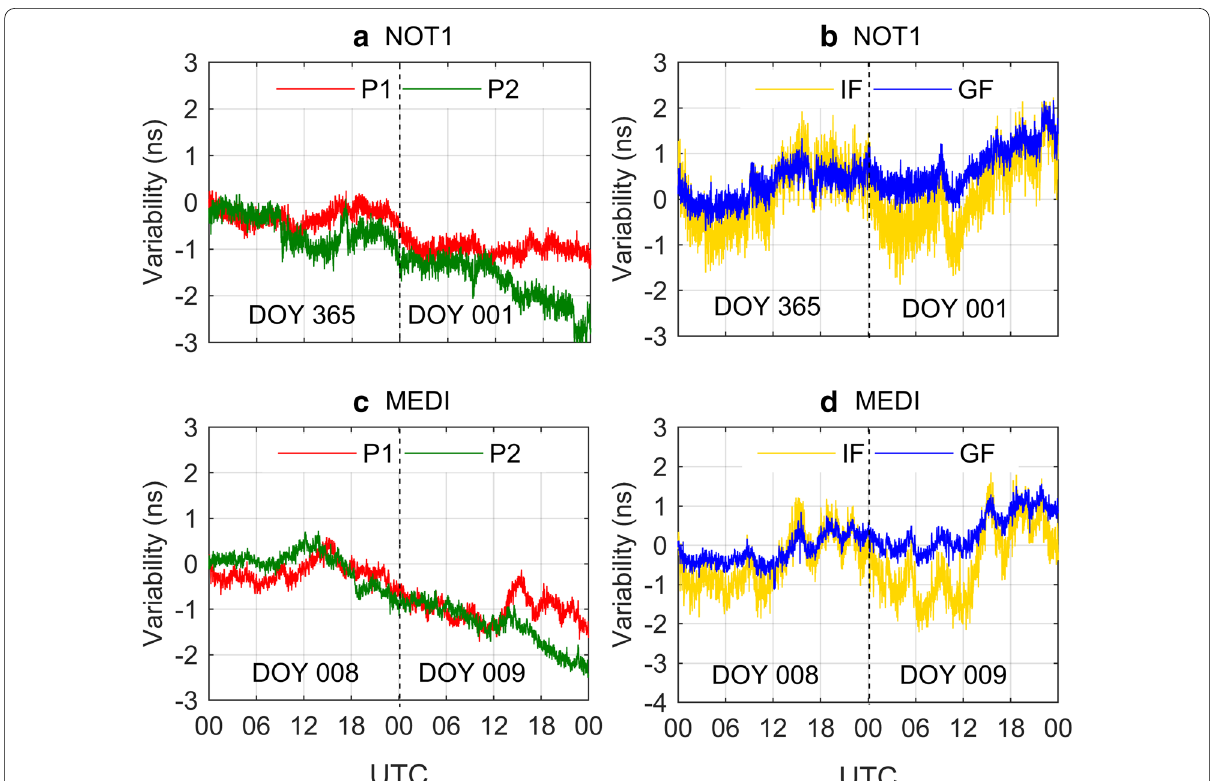
Fig. 2 Estimates of P1 (red lines) and P2 (green lines) receiver code biases and their ionosphere-free (gold line) and GF (blue line) combination on an epoch-by-epoch basis at stations NOT1 and MEDI for two consecutive days